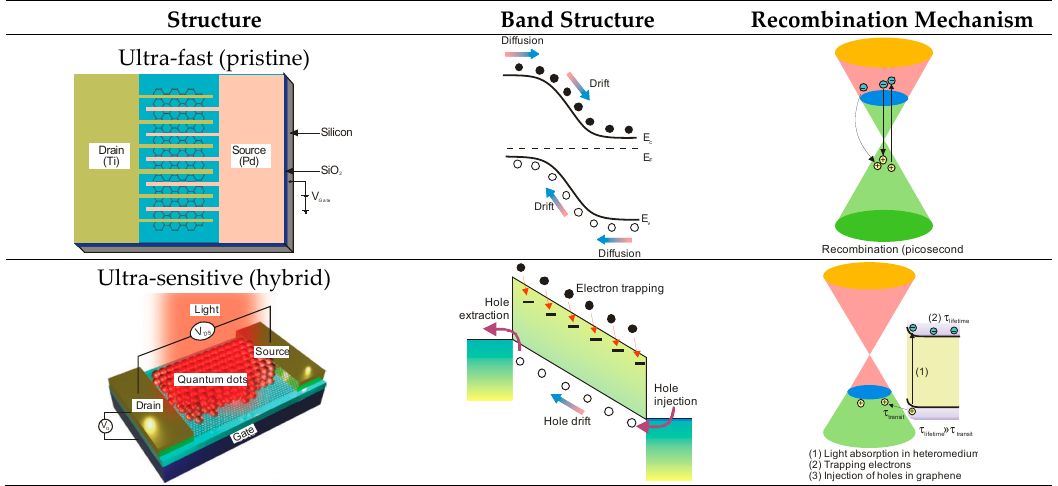
(1) Light absorption in heteromedium (2) Trapping electrons (3) Injection of holes in